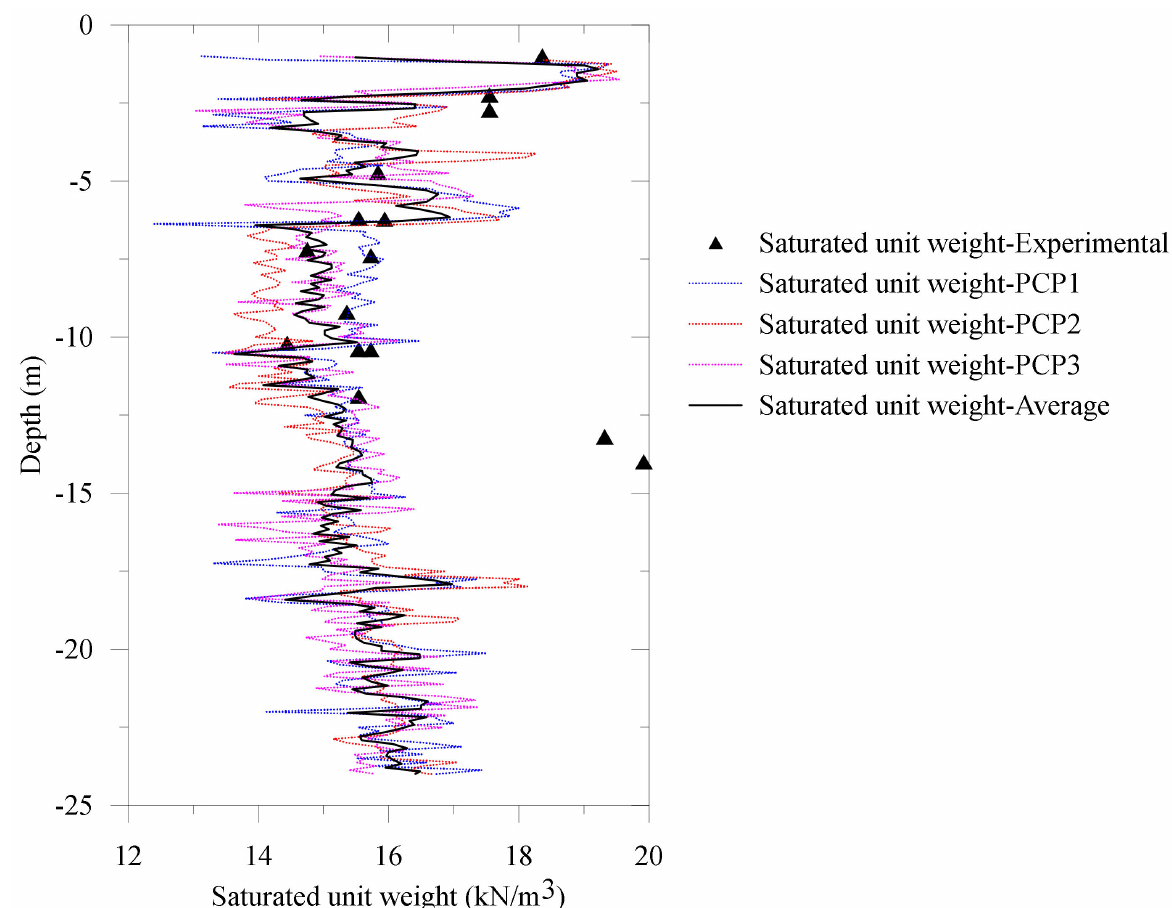
Figure 6. Saturated unit weight of the Nerang Broadbeach Roadway embankment